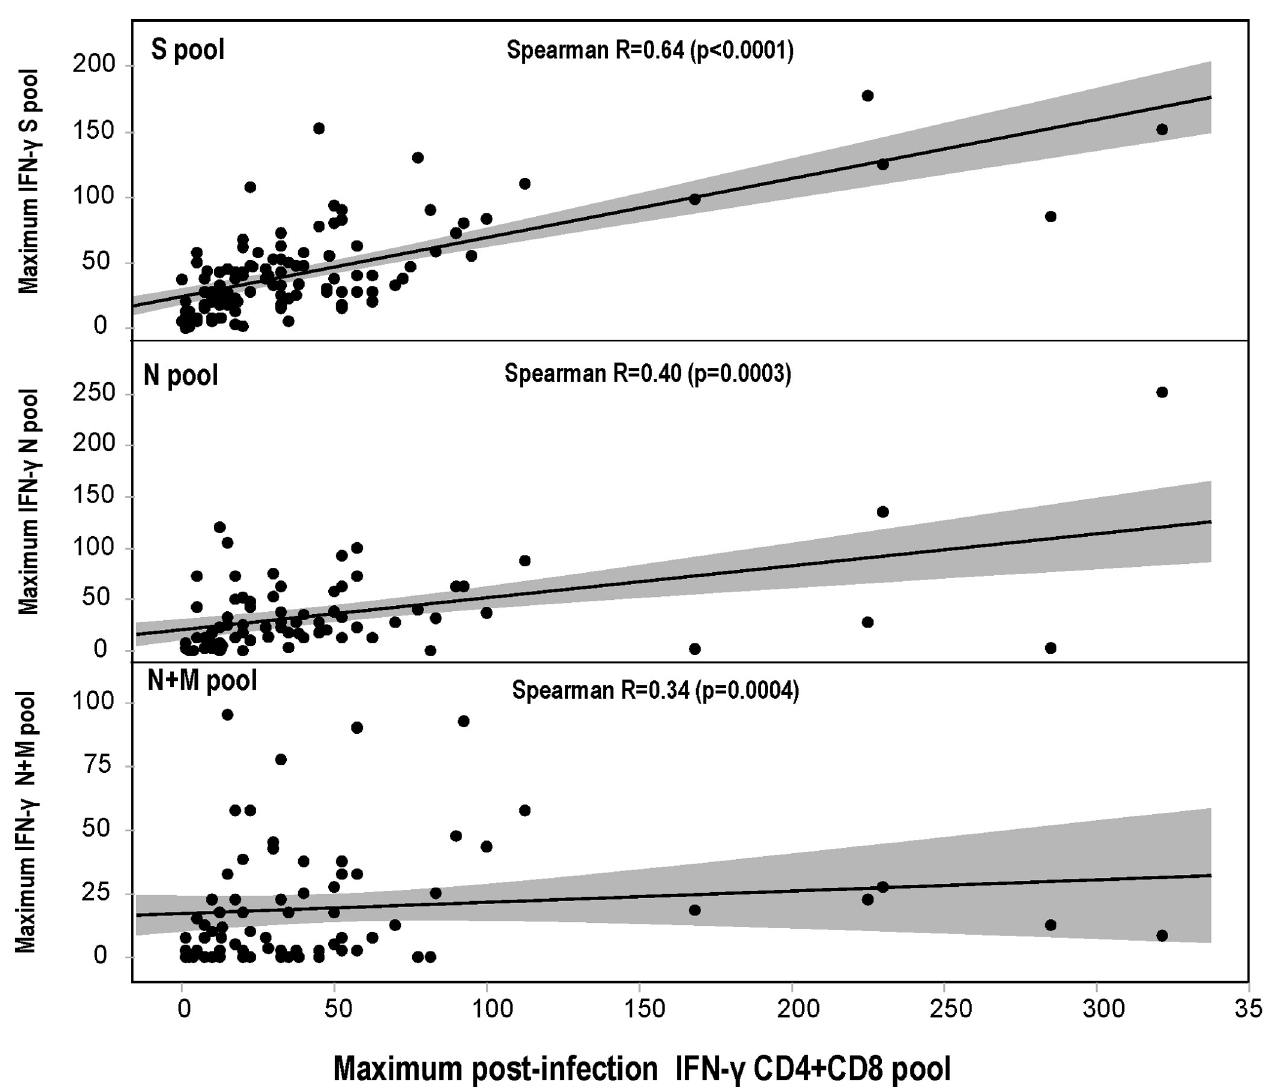
Fig 4. Correlations of the magnitude of IFN- γ responses post-infection to the S, N, and N+M pools with IFN- γ responses to the CD4+CD8 pool. The magnitudes of IFN- γ responses to the CD4+CD8 pool were compared to the magnitudes of IFN- γ responses to the S, N, and N+M pools. Using Spearman’s ranked correlations, IFN- γ responses to the S, N and N+M pools were significantly